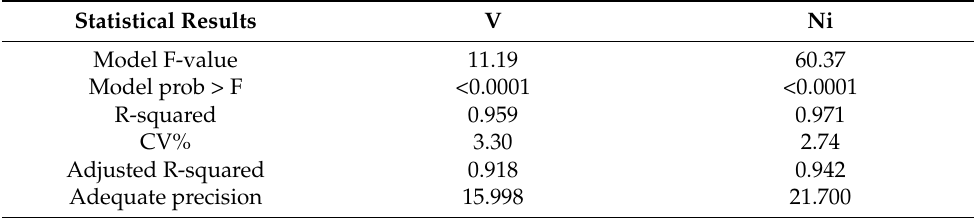
Table 4. Statistical results of the